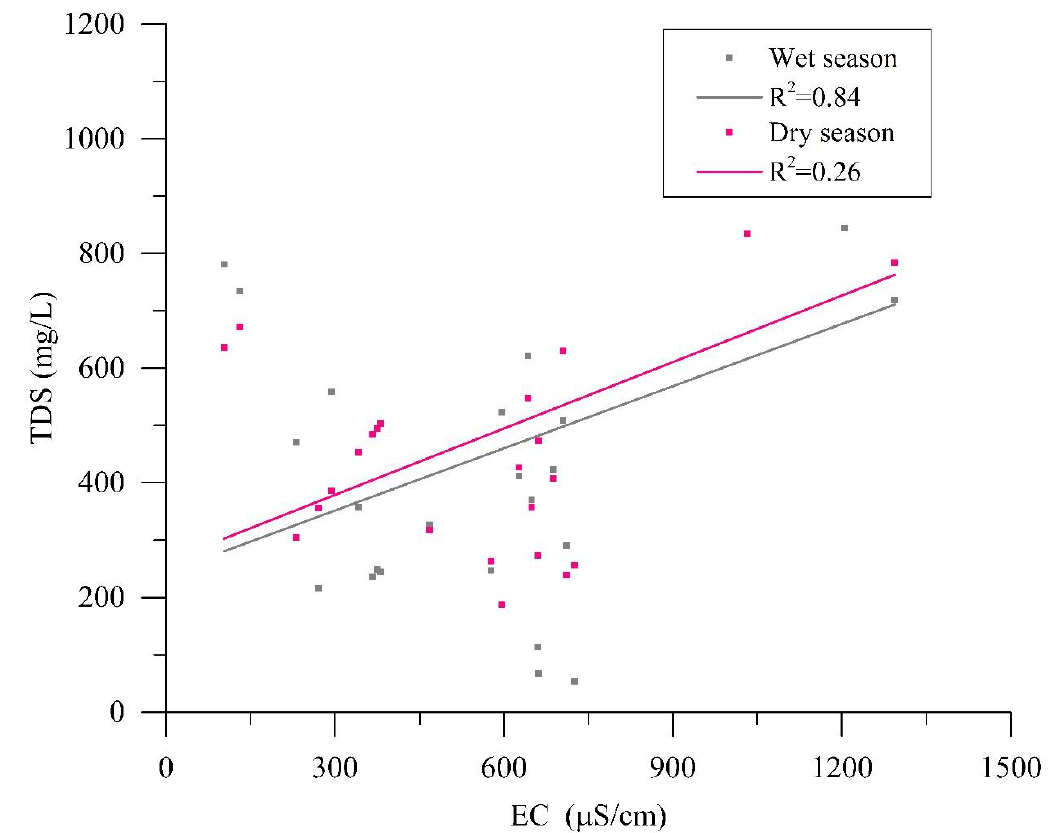
Figure 4. Relationship between total dissolved solids (TDS) and EC.